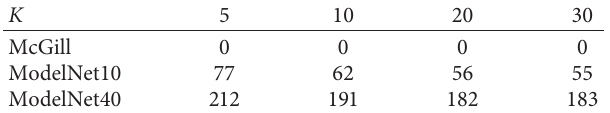
Table 3: Misclassified models given different K .